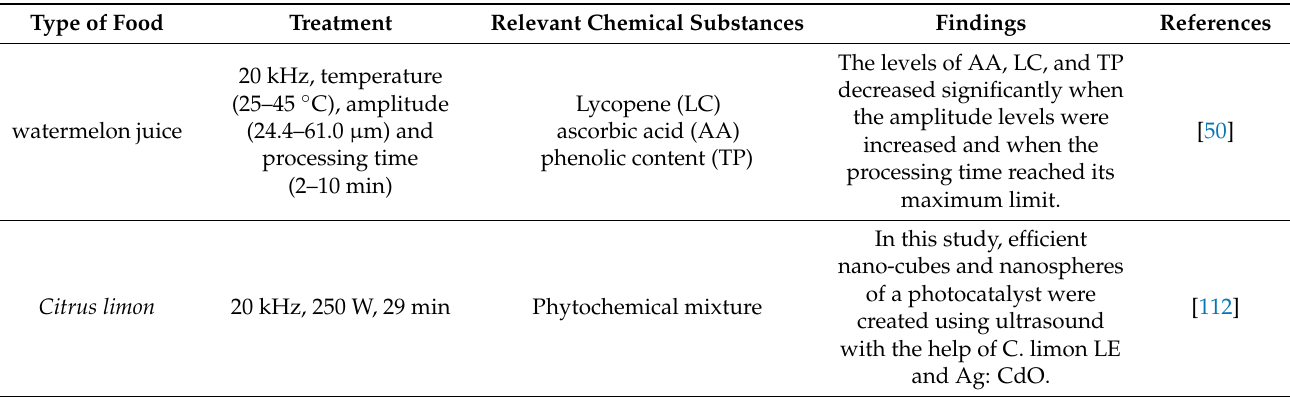
Table 2. The Influence of TS Processing on Phytochemicals and Bioactive Compounds in some food